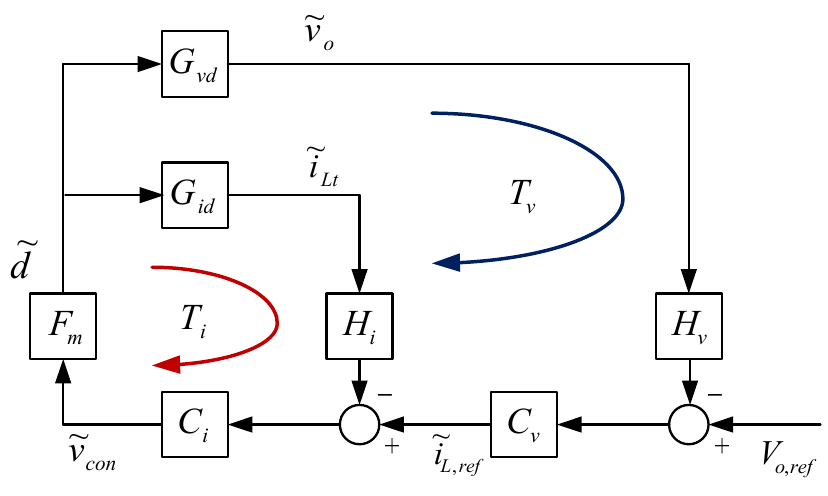
Figure 13. Block diagram of the closed-loop control